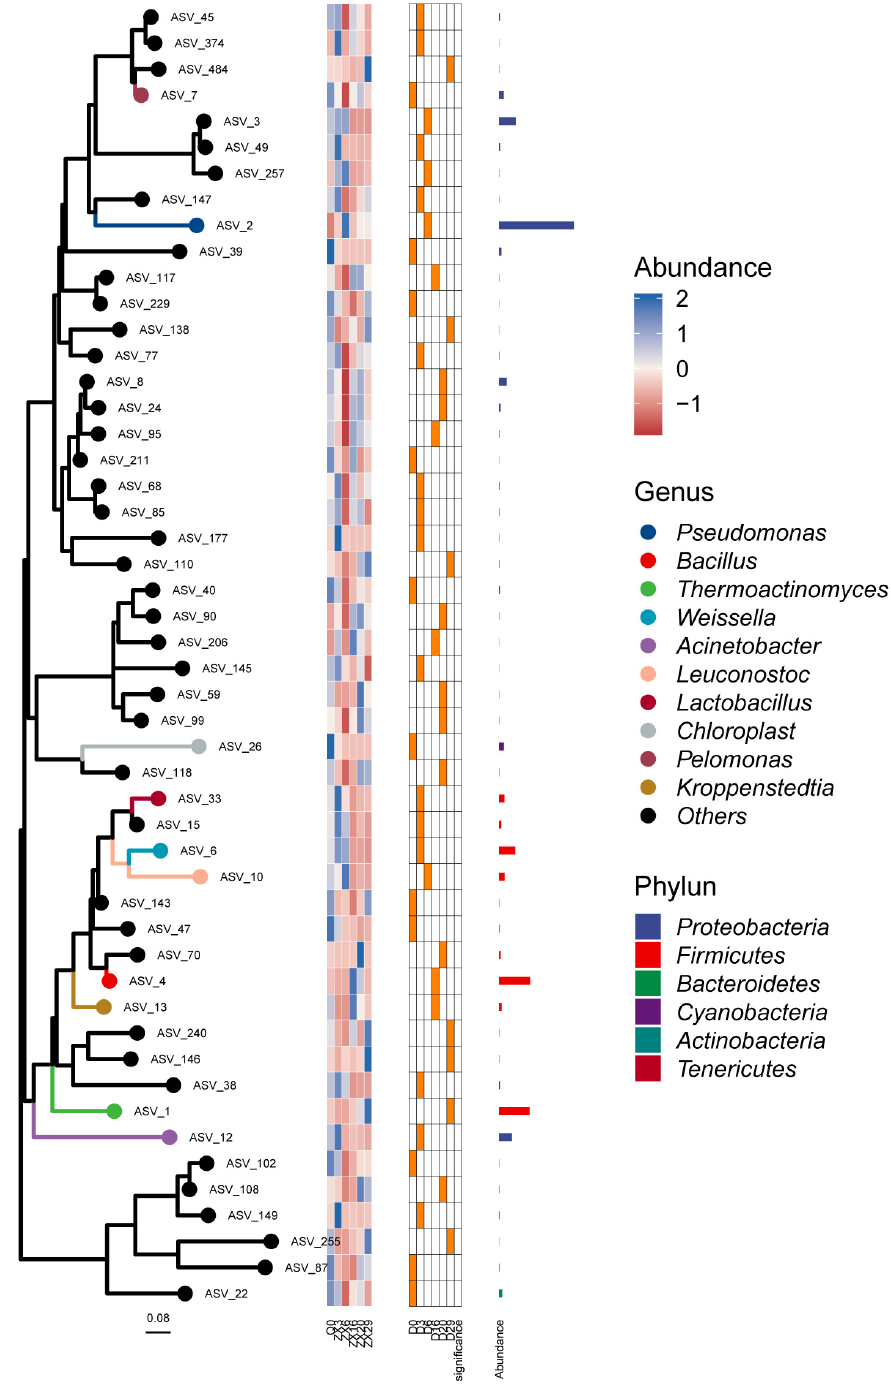
Figure 2. Taxonomic phylogenetic tree and species abundance heatmap of Daqu microorganisms (on the left is the phylogenetic tree constructed based on ASV, and in the middle is the abundance and significance of species at ASV level) ( p < 0.05).